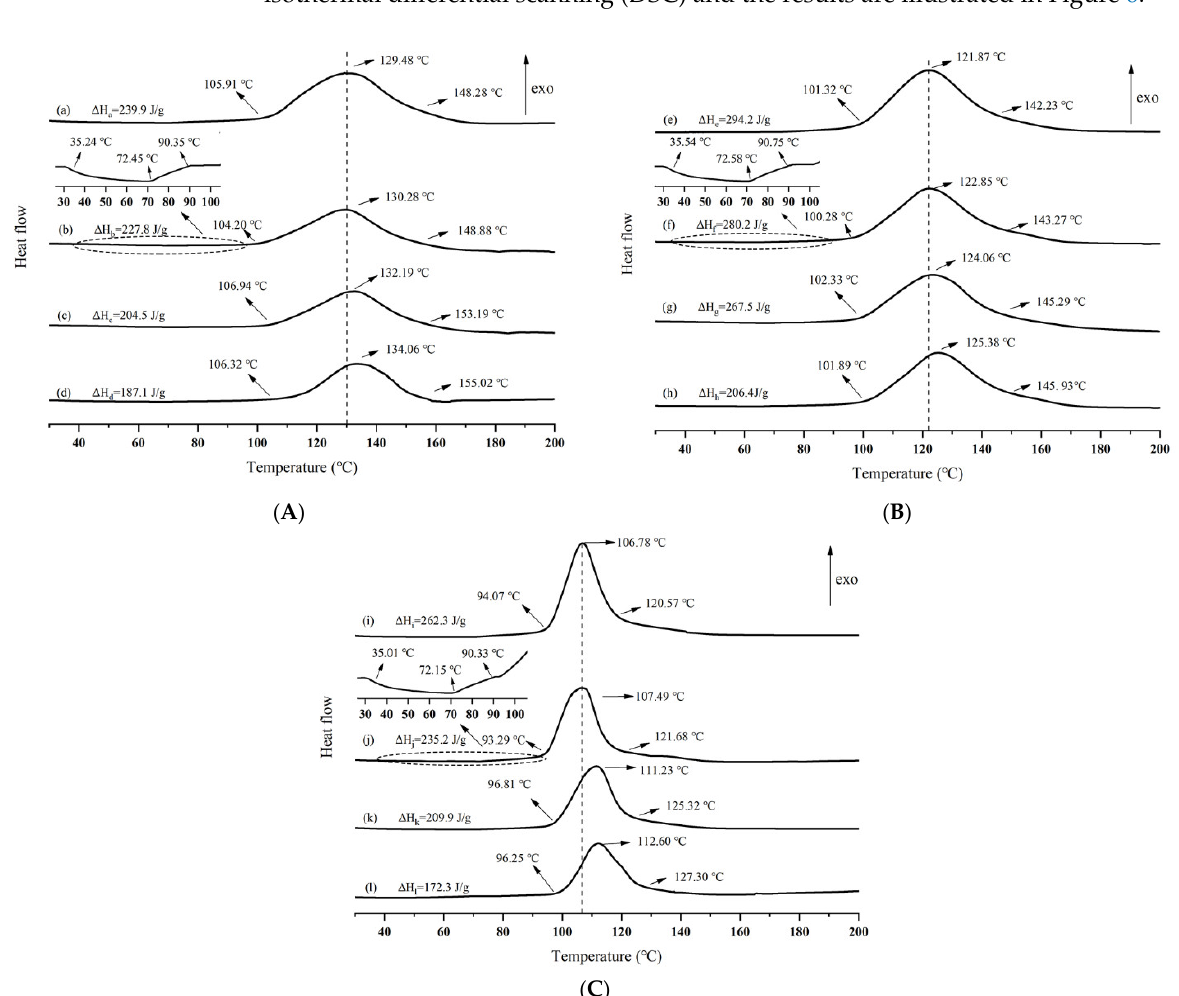
Figure 6. Non-isothermal Differential Scanning Calorimetry curves of ( A ) wherein is ( a ) pure UPR, ( b ) UPR + 20.00 phr of long chopped glass fiber, ( c ) UPR + 2.50 phr of NH 4 HCO 3 , ( d ) UPR + 20.00 phr of long chopped glass fiber + 2.50 phr of NH 4 HCO 3 , in presence of MEKP-II and cobalt naphthenate; ( B ) wherein is ( e ) pure UPR, ( f ) UPR + 20.00 phr of long chopped glass fiber, ( g ) UPR + 2.50 phr of NH 4 HCO 3 , ( h ) UPR + 20.00 phr of long chopped glass fiber + 2.50 phr of NH 4 HCO 3 , in presence of CYHP and cobalt naphthenate; ( C ) wherein is ( i ) pure UPR, ( j ) UPR + 20.00 of phr long chopped glass fiber, ( k ) UPR + 2.50 phr of NH 4 HCO 3 , ( l ) UPR + 20.00 phr of long chopped glass fiber + 2.50 phr of NH 4 HCO 3 , in presence of TBPO and cobalt